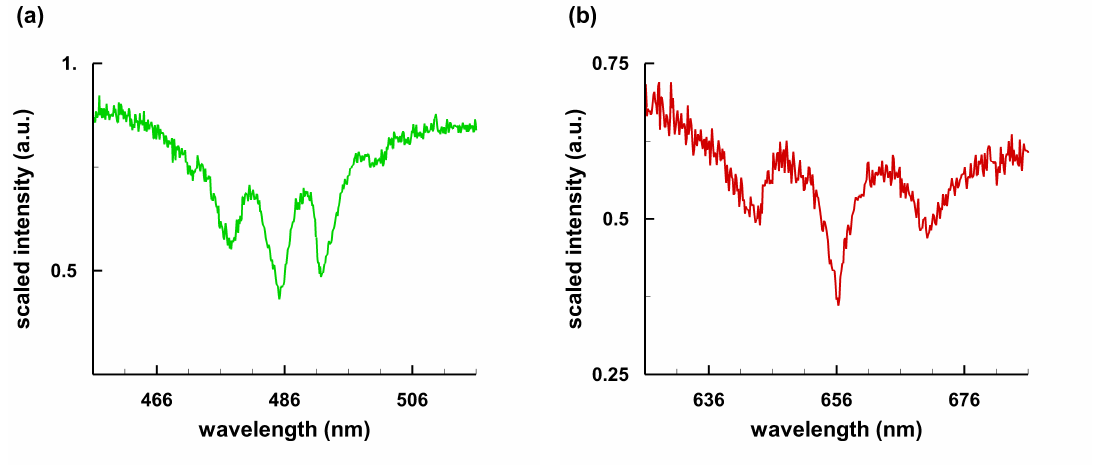
Figure 5. Magnetic white dwarf HS 1031 + 0343 spectra [56]: ( a ) H β ; and ( b ) H α